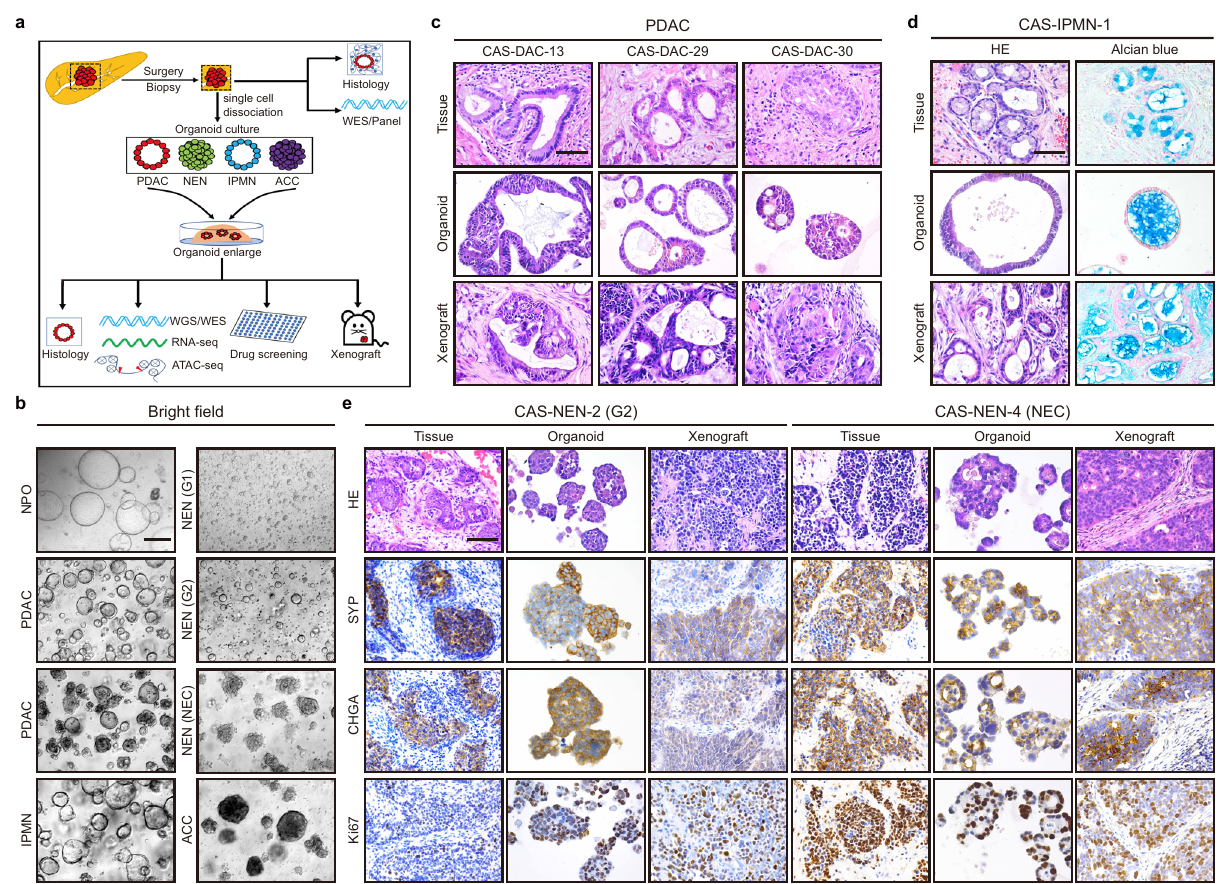
Fig. 1 Establishment and histological characterization of PDPCOs. a Overview of the study. A total of 84 PDPCO lines, including PDAC, NEN, IPMN and ACC, were established by samples obtained by surgery or EUS-FNA. Original tissues were used for histological examination and WES/panel sequencing. PDPCOs were subjected to engraftment, histological examination, WGS/WES, RNA-seq, ATAC-seq and drug screening. b Representative bright fi eld image of PDPCOs generated from normal pancreas, PDAC, IPMN, NEN and ACC tissue. Scale bar, 200 μ m. Experiments are repeated at least three times with similar results. c , Representative H&E staining of PDAC primary tumors, organoids, and xenografts (CAS-DAC-13, CAS-DAC-29 and CAS-DAC-30). Scale bar, 50 μ m. Experiments are repeated at least three times with similar results. d Representative H&E and alcian blue staining of an IPMN primary tissue, organoid and xenograft (CAS-IPMN-1). Scale bar, 50 μ m. Experiments are repeated at least three times with similar results. e Representative H&E, SYP, CHGA and Ki67 staining of NEN primary tissues, organoids and xenografts (CAS-NEN-2 and CAS-NEN-4). CAS-NEN-2 was clinically diagnosed as WHO grade G2, while CAS-NEN-4 was diagnosed as NEC. Scale bar, 50 μ m. Experiments are repeated at least three times with similar results. PDPCO, patient- derived pancreatic cancer organoid; PDAC, pancreatic ductal adenocarcinoma; NEN, pancreatic neuroendocrine neoplasm; IPMN, intraductal